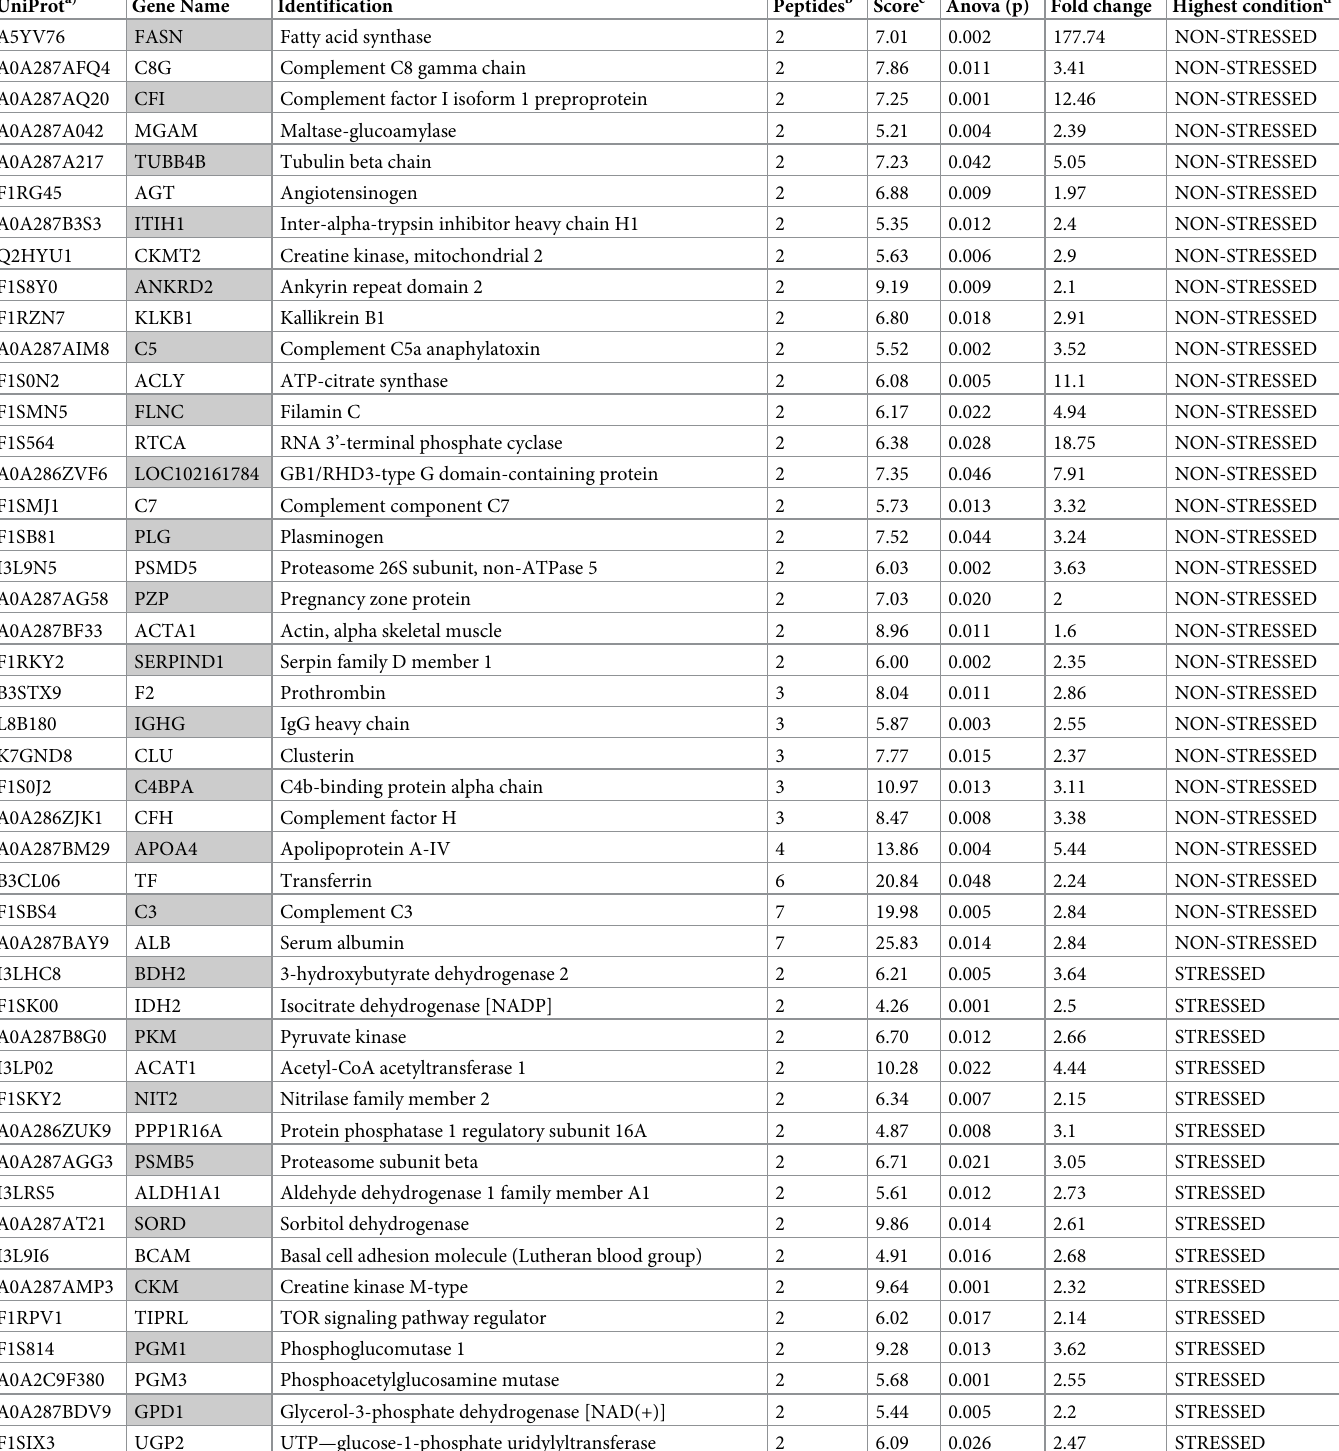
Table 1. 66 proteins identified with altered levels in response to transport stress (stressed) compared to short road transportation (non-stressed) following label- free MS/MS analysis (Progenesis QI for proteomics). UniProt